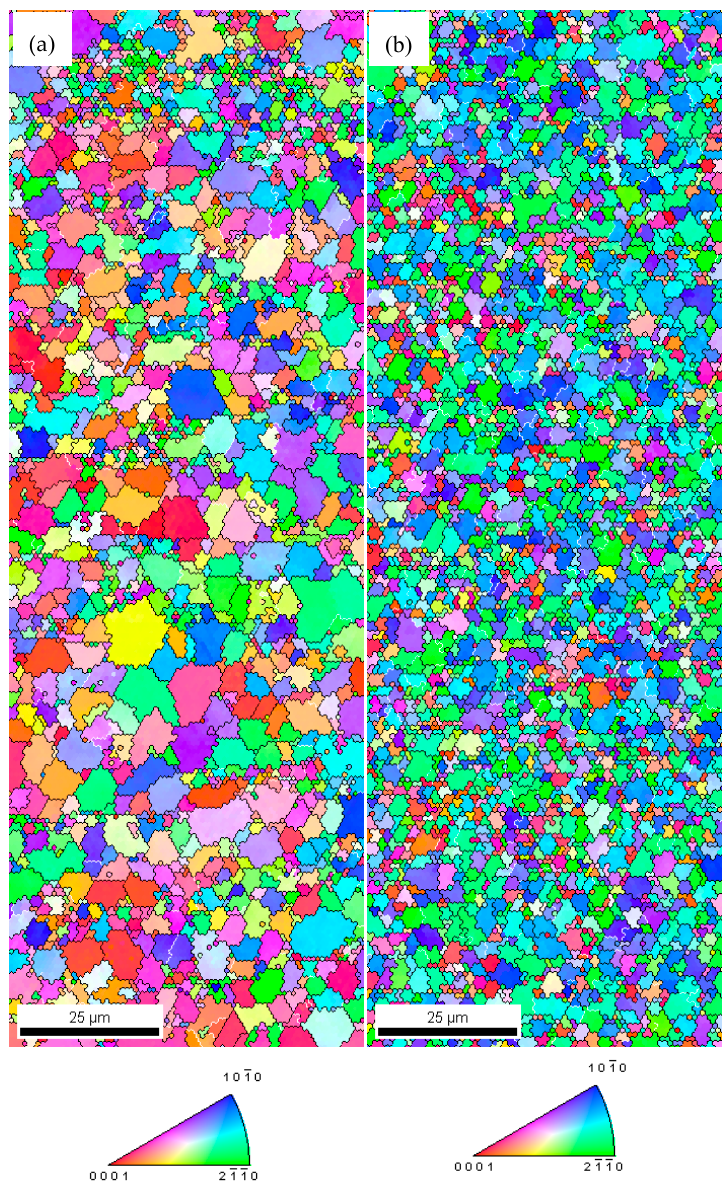
Figure 6. EBSD analysis of nano-SiCp/AZ91 composite after multi-pass forging for ( a ) nine passes (400-6P + 350-3P) and ( b ) 12 passes (400-6P + 350-3P + 300-3P).